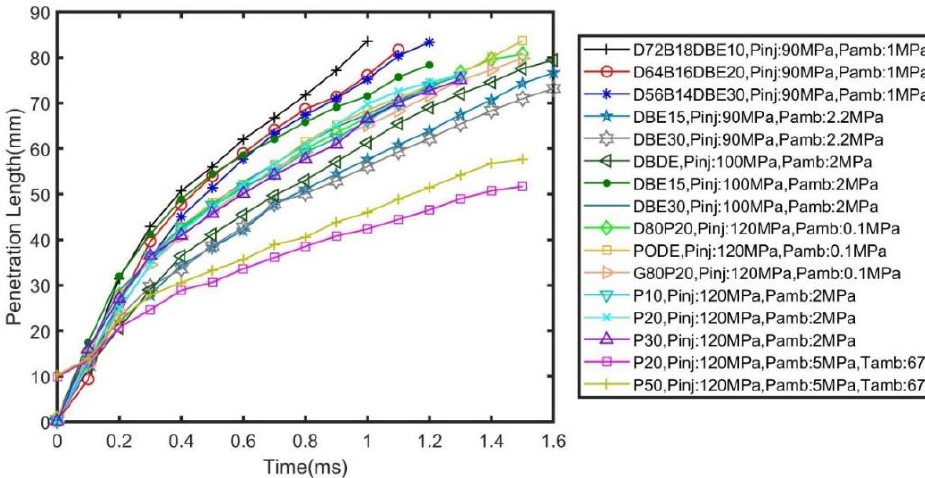
Figure 7. PL for various ether-based additives (such as DBE, PODE) with diesel at various injection & ambient pressure [30,74 – 77].